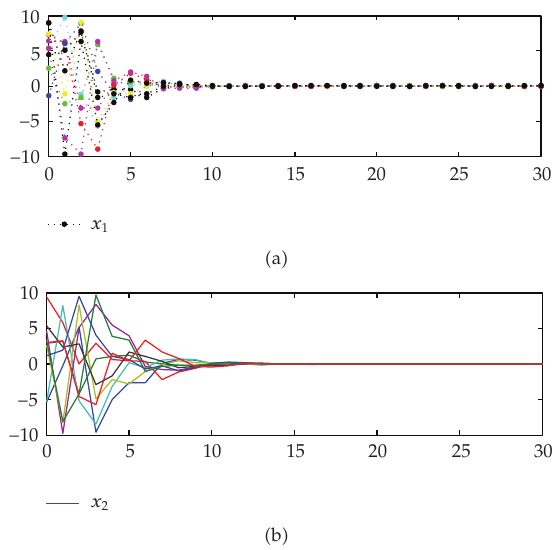
Figure 1: Global convergence of states x 1 and x 2 in Example 5.1, when d 1 (cid:8) 1 and d 2 (cid:8)